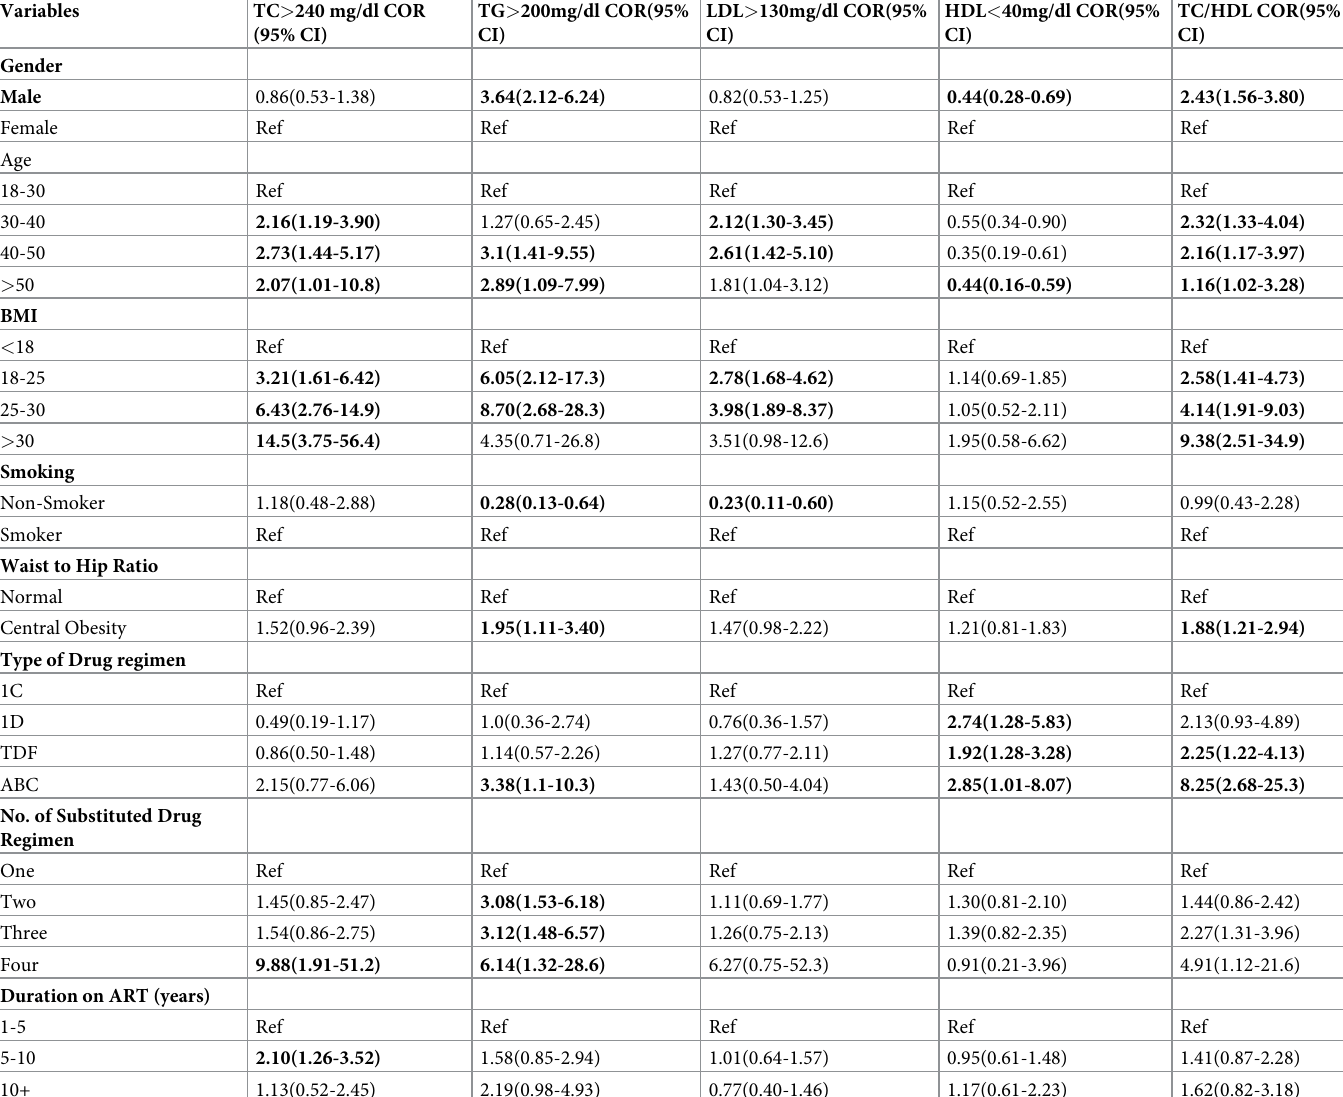
Table 5. Univariate logistic regression model for factors associated with abnormal lipid profiles among HIV infected patients in Asmara,